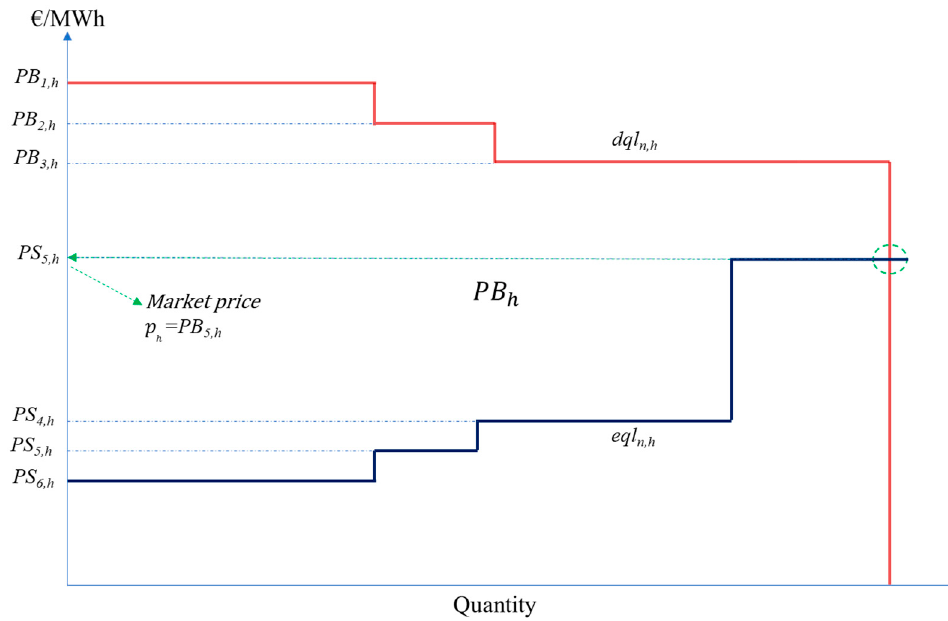
Figure 4. LEM demand and supply curves based on opportunity costs and benefits.